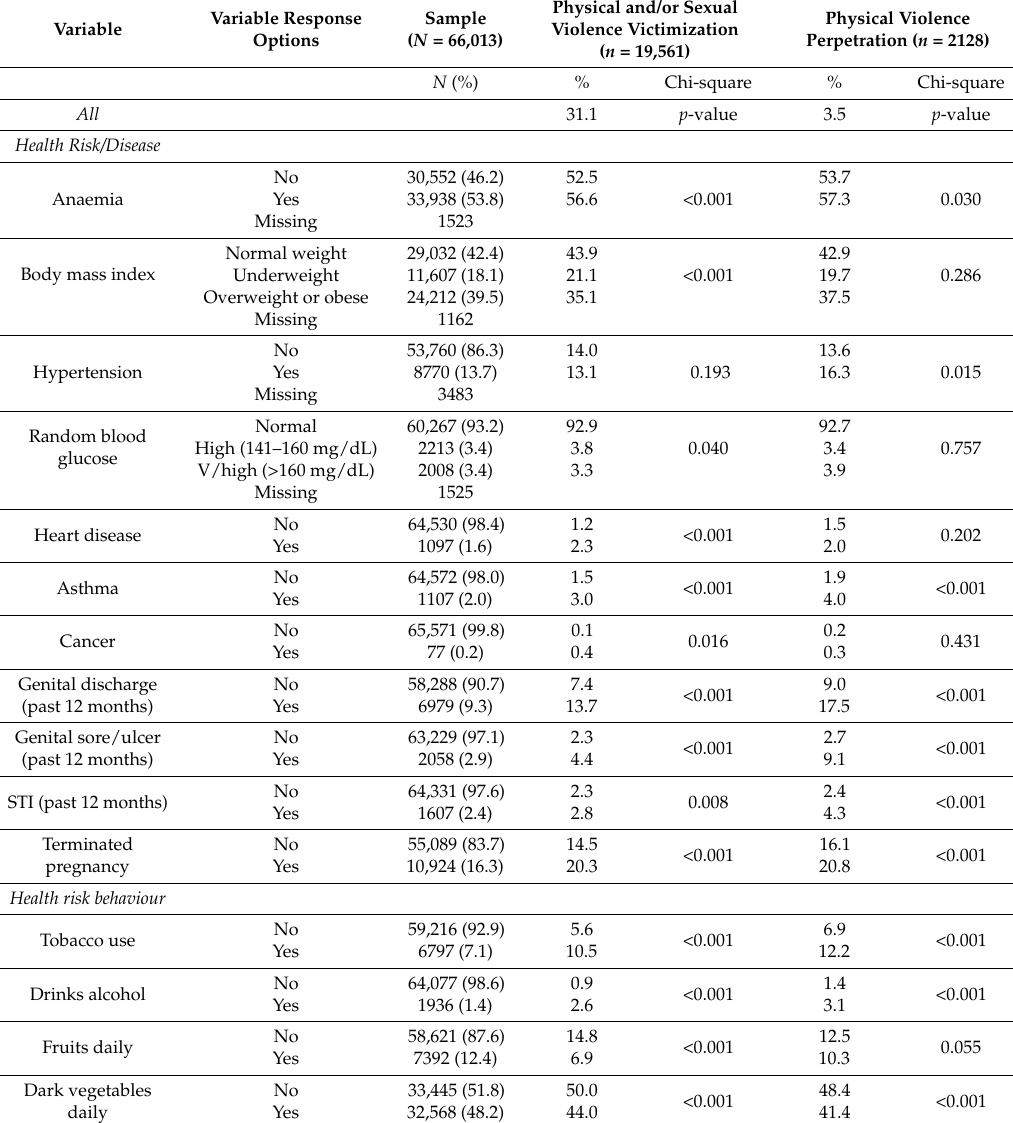
Table 2. Sample description by health and violence